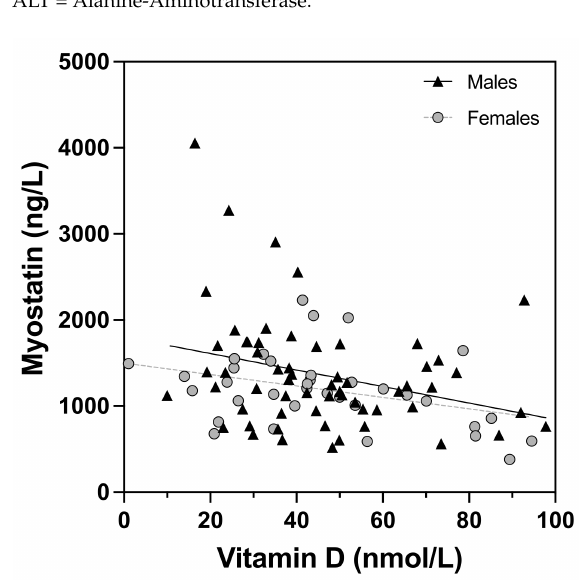
Figure 2. Correlation of myostatin with vitamin